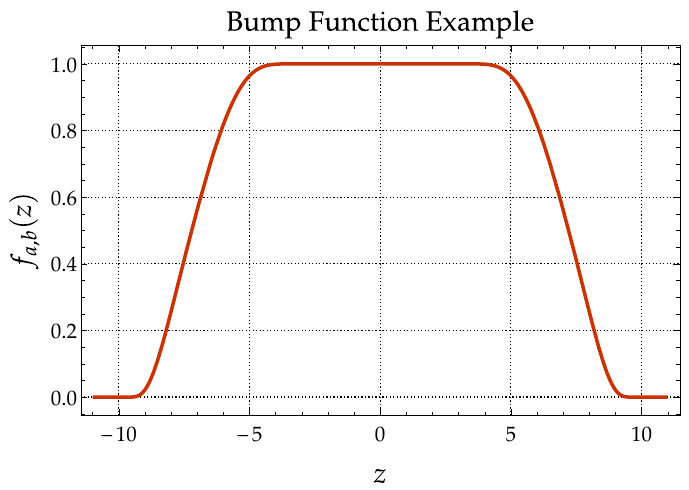
Figure 2. An illustration of the bump function given by Equation (189), with a = 2 and b = 10. The algebra becomes arbitrarily involved in this case; for this reason, we opt to only show our results and the functions we chose. The bump function used